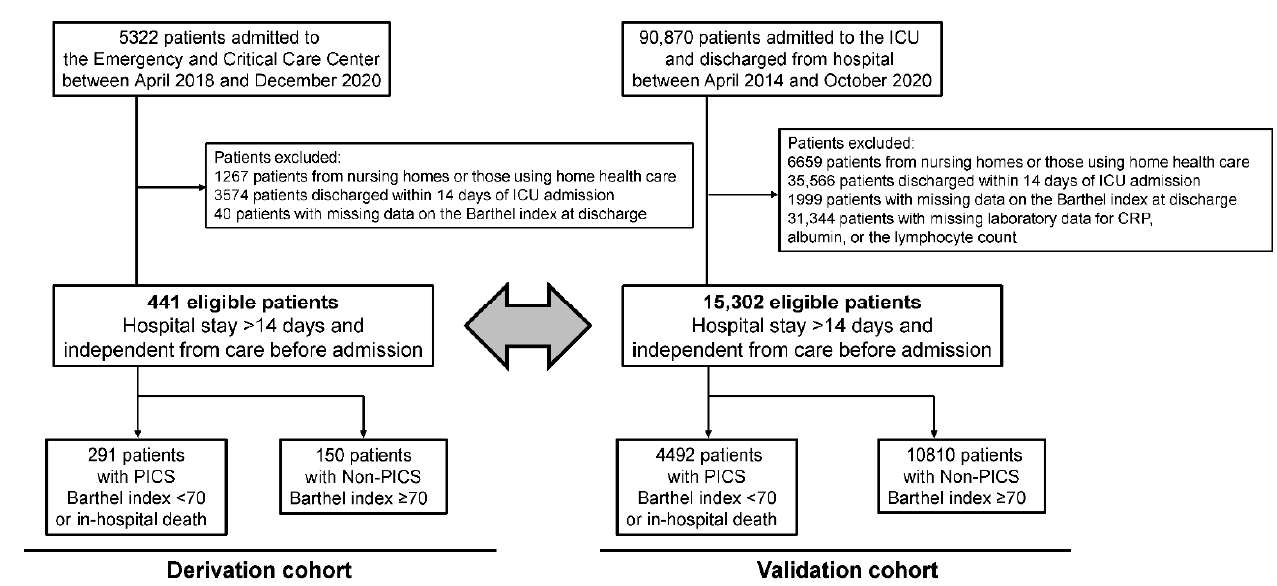
Figure 1. Patient flow. Abbreviations: ICU, intensive care unit; CRP, C-reactive protein; PICS, persistent inflammation, immunosuppression, and catabolism syndrome; Non-PICS, non-persistent inflammation, immunosuppression, and catabolism syndrome. Table 1. Patient characteristics in the derivation cohort according to the PICS status.